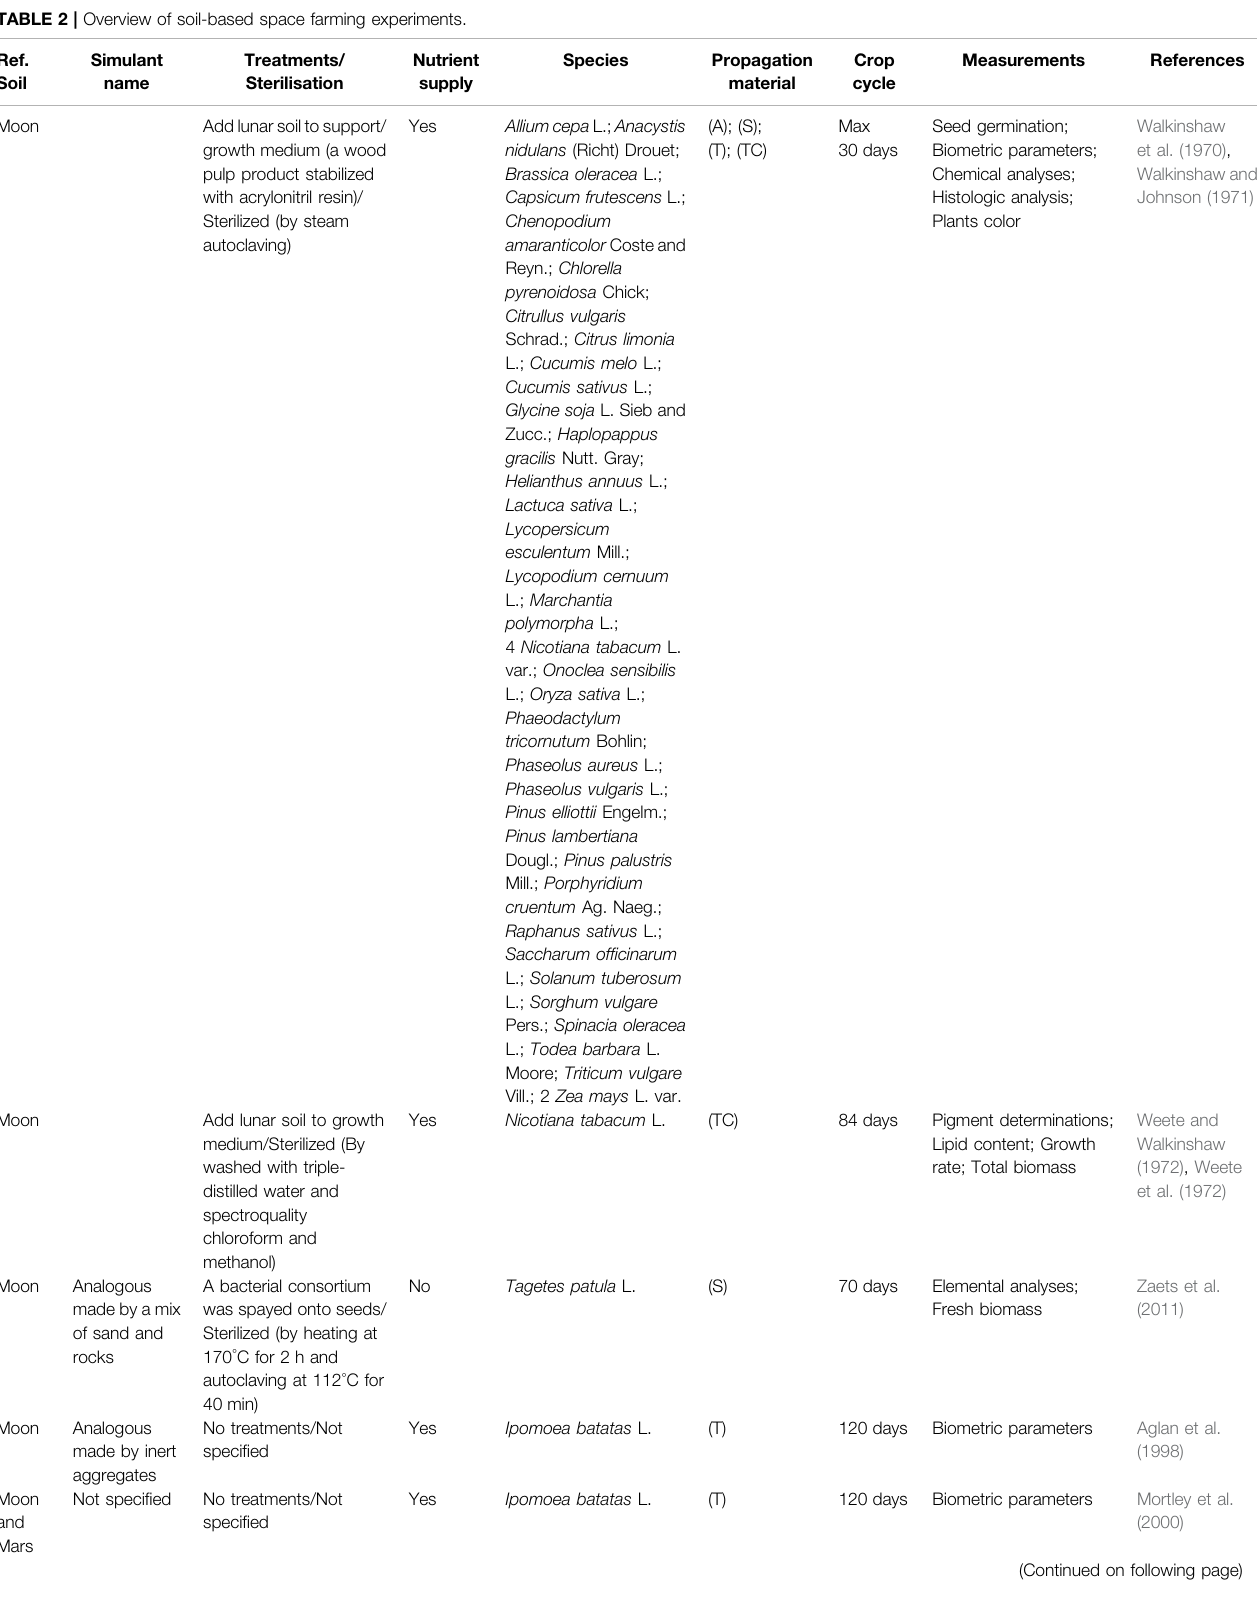
TABLE 2 | Overview of soil-based space farming experiments. Ref.